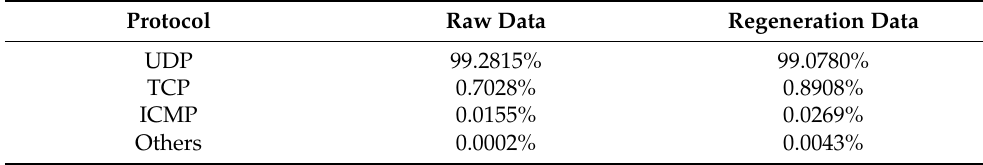
Table 4. Network Packet Protocol Proportion Information.